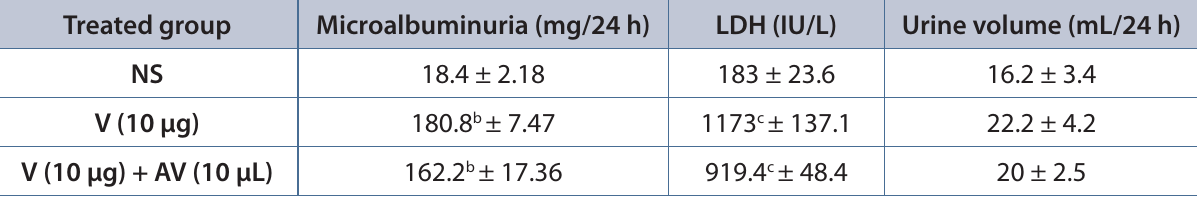
Table 2. Effectiveness of immediately administered IM antivenom on microalbuminuria and increase of urinary LDH enzyme following SC injection of H. lepturus venom-treated rats (n = 5); normal saline was administered in the control group instead of venom Treated